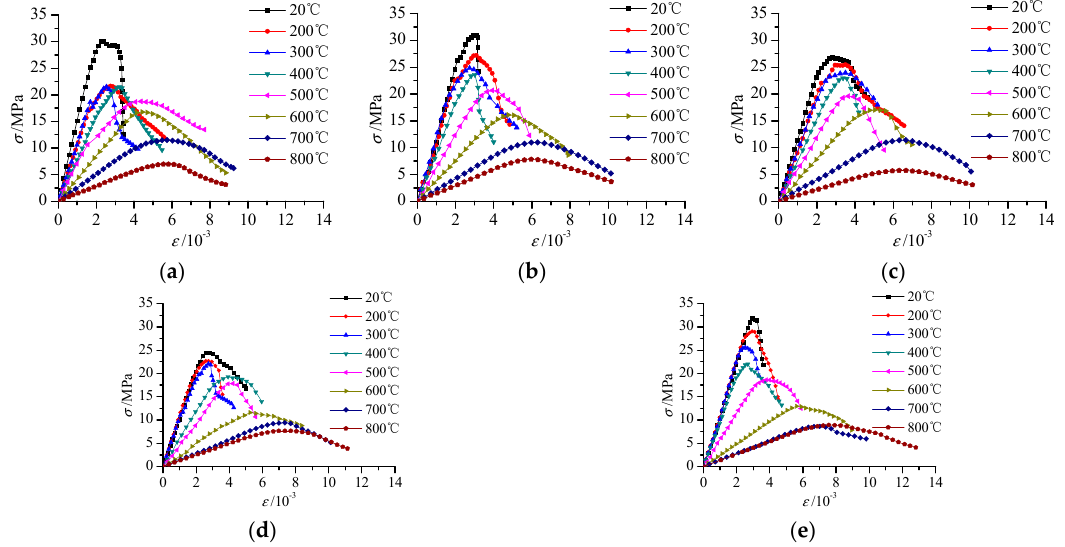
Figure 8. Stress-strain curves of recycled aggregate concrete (RAC) prism specimens. ( a ) r = 0%; ( b ) r = 30%; ( c ) r = 50%; ( d ) r = 70%; ( e ) r = 100%.